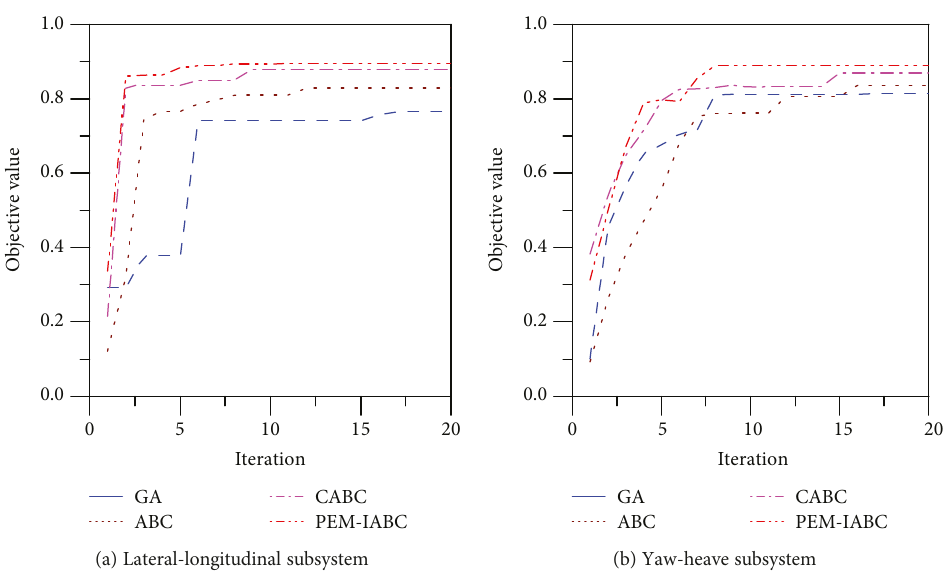
Figure 5: Evolving curves of the four